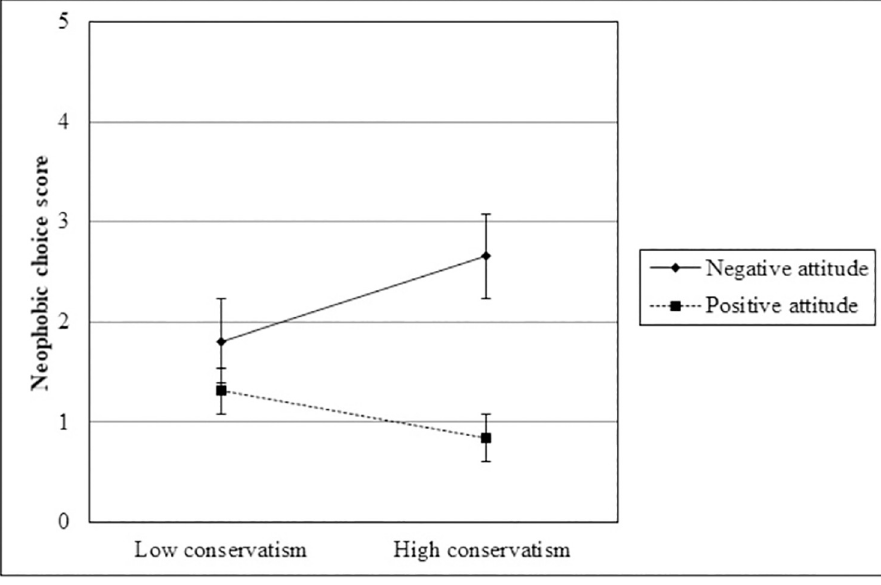
Fig 3. Neophobic choices as a function of socio-political ideology moderated by the experimental condition (Study 4). Note: Error bars represent standard errors.